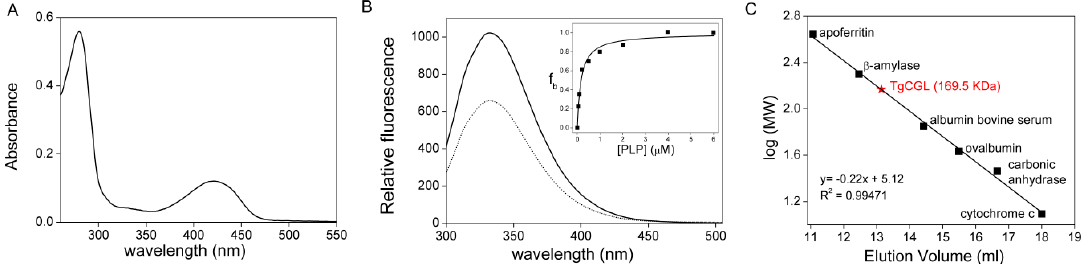
Figure 2. Properties of recombinant TgCGL. ( A ) Absorption spectrum of purified TgCGL recorded in a solution containing 12 µM protein in 50 mM MBP buffer pH 9. ( B ) Fluorescence spectra (excitation was at 280 nm) of holo-TgCGL (dotted line) and apo-TgCGL (solid line) in 50 mM Bis-Tris-propane pH 9, at a concentration of 1 µM. ( Inset ) Representative titration of apo-TgCGL with PLP. The apo-protein was incubated with PLP at different concentrations for 15 min at 25 °C in 50 mM Bis-Tris-propane pH 9 before determination of the fluorescence emission variations at 332 nm upon excitation at 280 nm. The smooth curve shows the best fit to the data with K d = 0.17 ± 0.04 µM. ( C ) Analytical gel filtration chromatography of TgCGL. The calibration curve used to estimate the native molecular weight based on the elution position during analytical gel filtration is indicated.